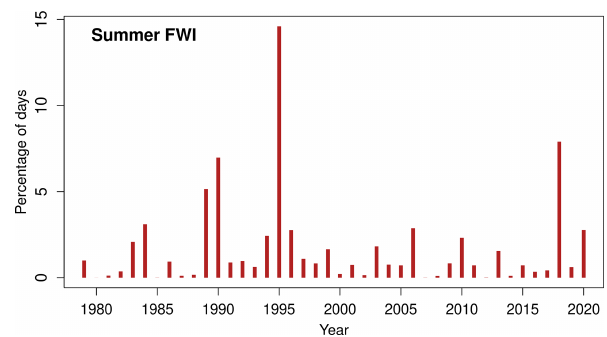
Figure 3. Annual burned area (km 2 ) for the UK, estimated from MODIS MCD64A1 (2003–2020) and EFFIS (2008–2020).